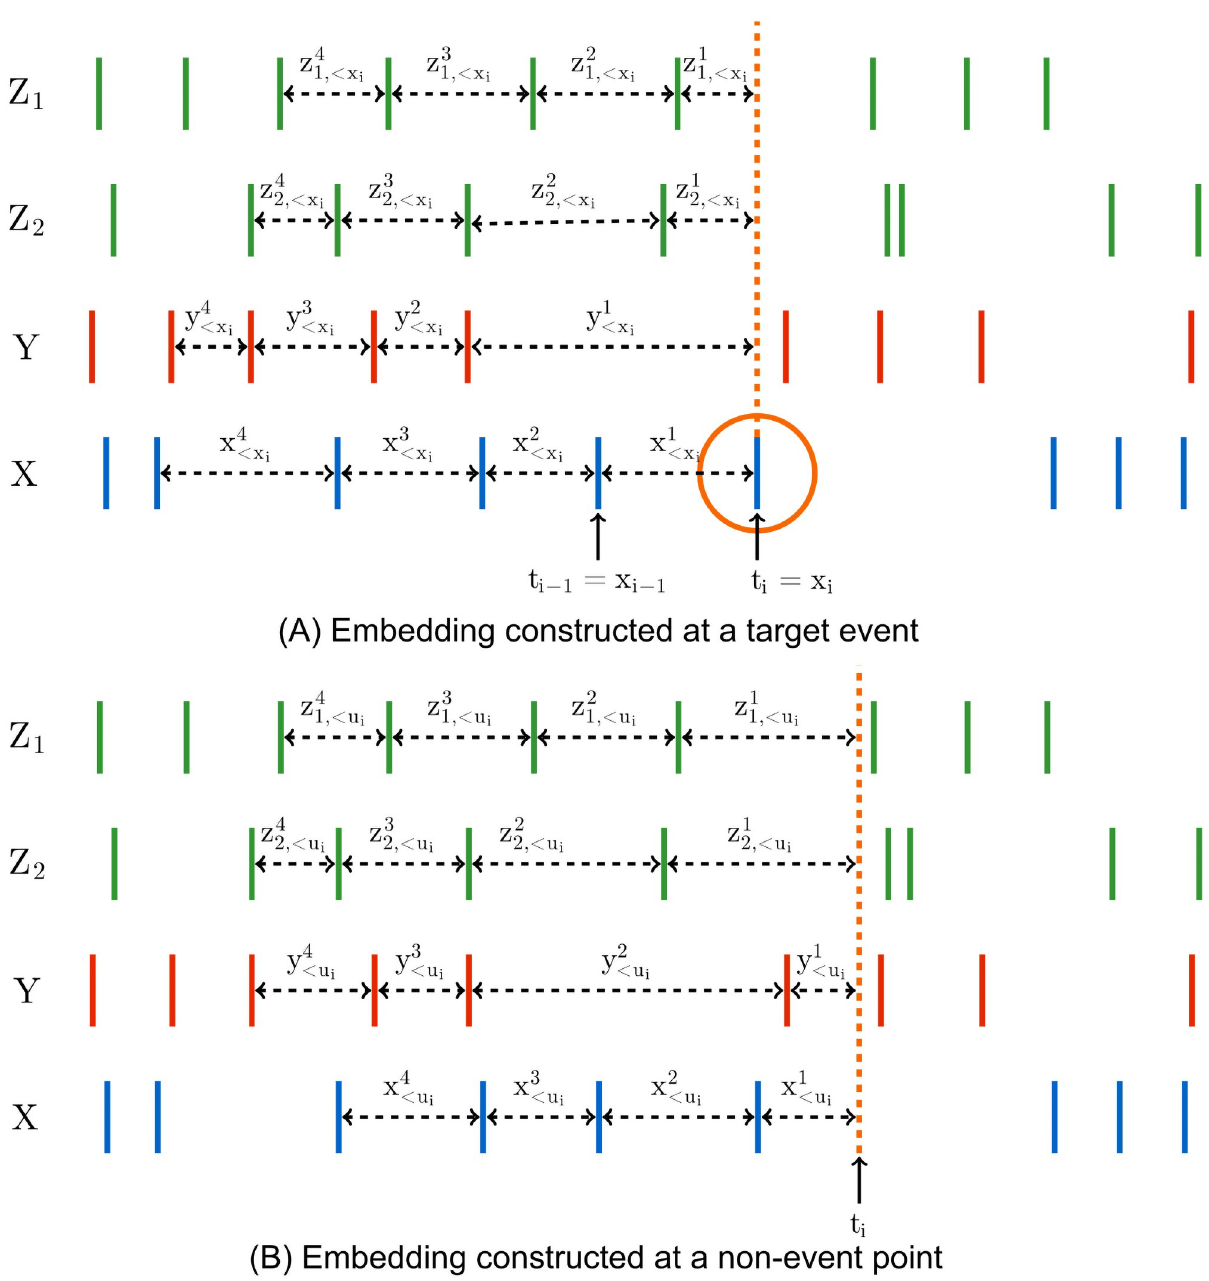
Fig 10. Examples of history embeddings. (A) shows an example of a joint embedding constructed at a target event ( j of a joint embedding constructed at a sample event ( j